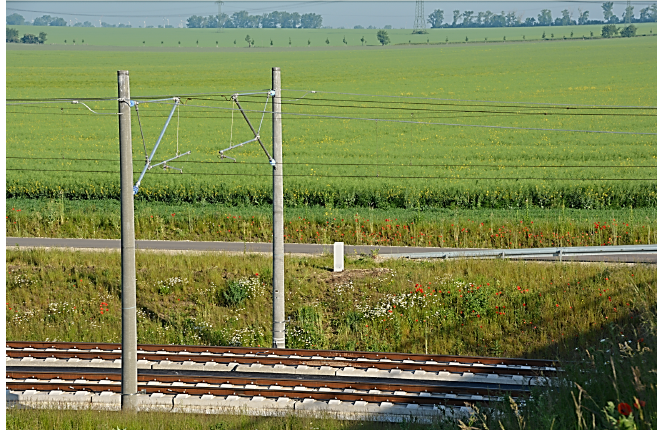
Figure 1. The catenary pole system for high-speed rail